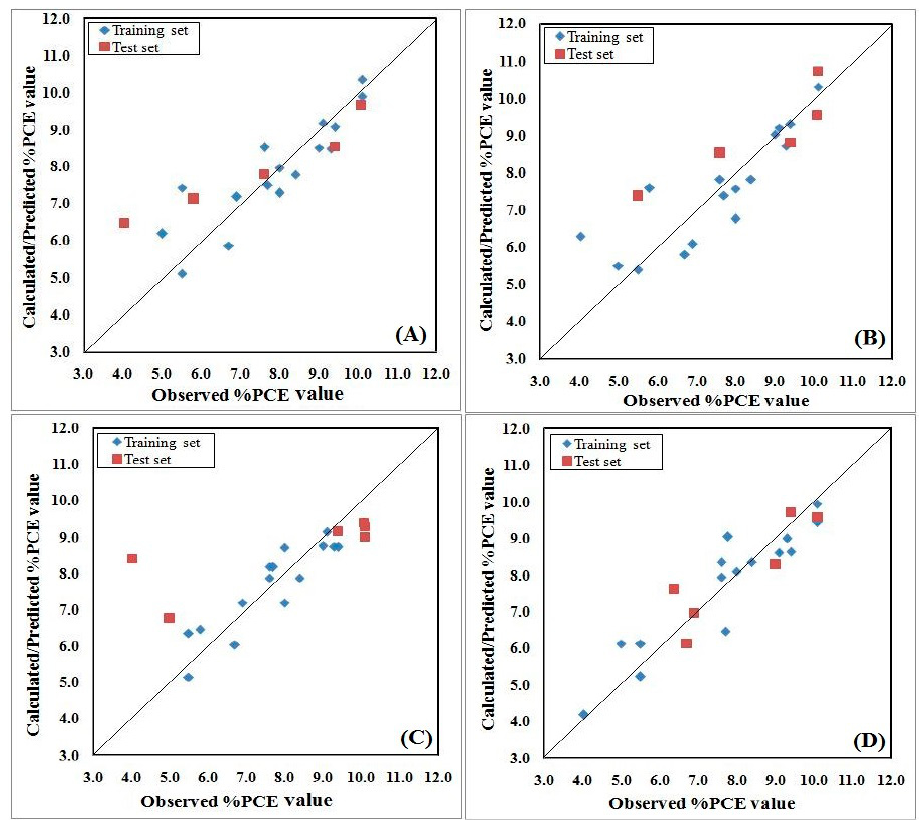
Figure 3. Scatter plots of QSPR models developed with the following dataset splitting methods: ( A ) Activity sorted; ( B ) Euclidean distance based; ( C ) Kennard–Stone based; and ( D ) K-Medoid clustering.